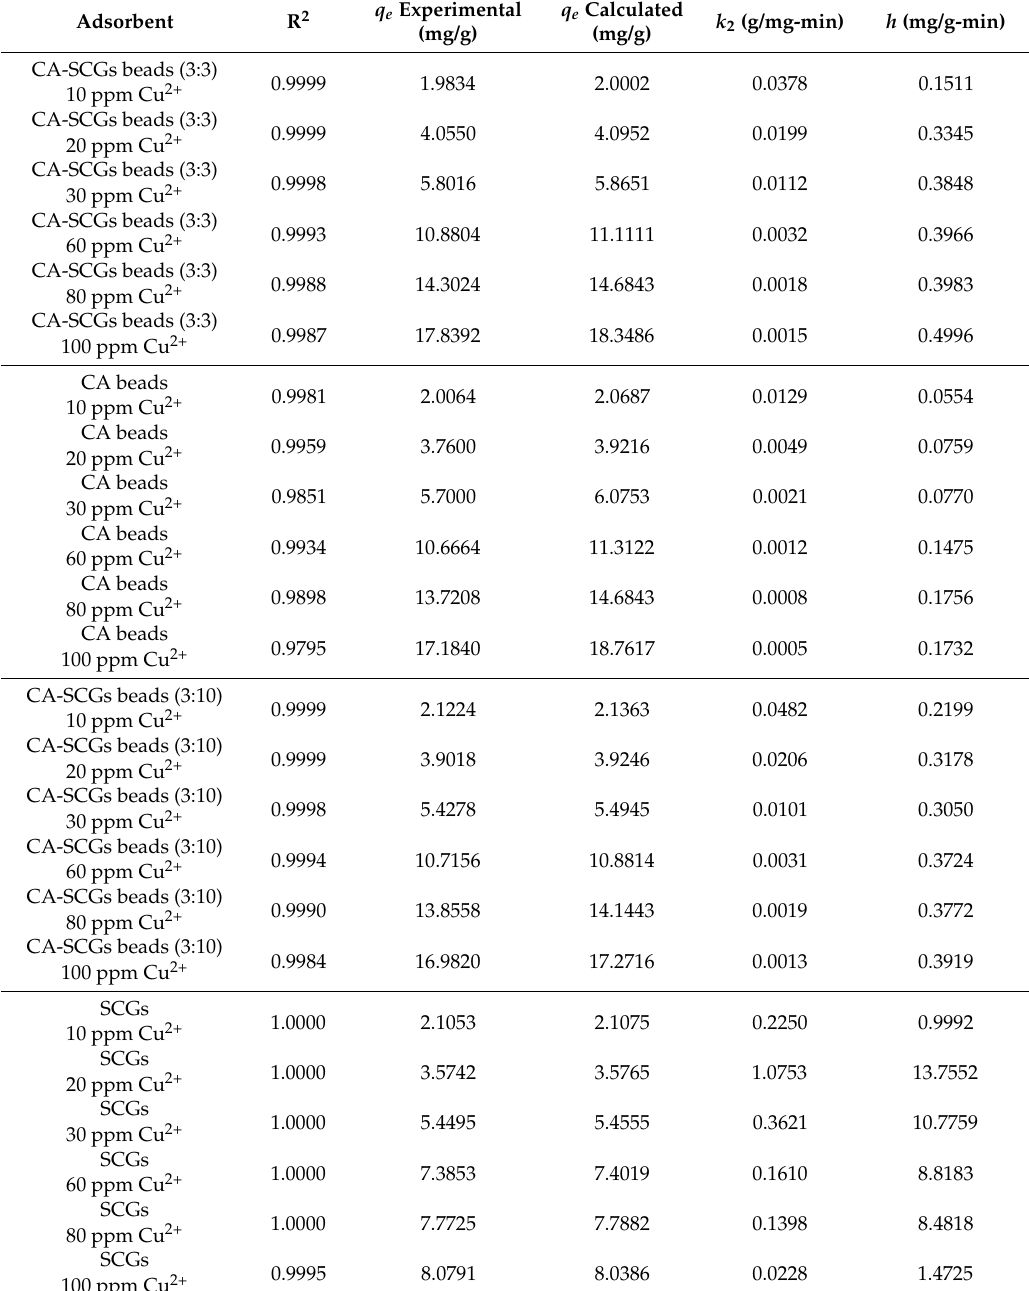
Table 2. Pseudo-second-order adsorption kinetic